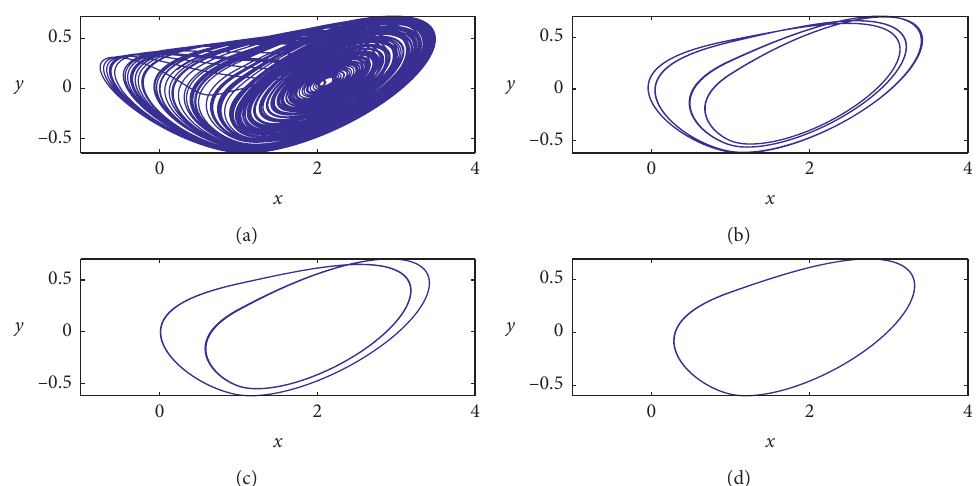
Figure 5: The period doubling scenario in the modified Chua’s chaotic circuit shown in Figure 1: (a) single band chaotic attractor ( R � 1734 Ω ) , (b) period-4 limit cycle ( R � 1770 Ω ) , (c) period-2 limit cycle ( R � 1775 Ω ) , and (d) period-1 limit cycle ( R � 1801 Ω )